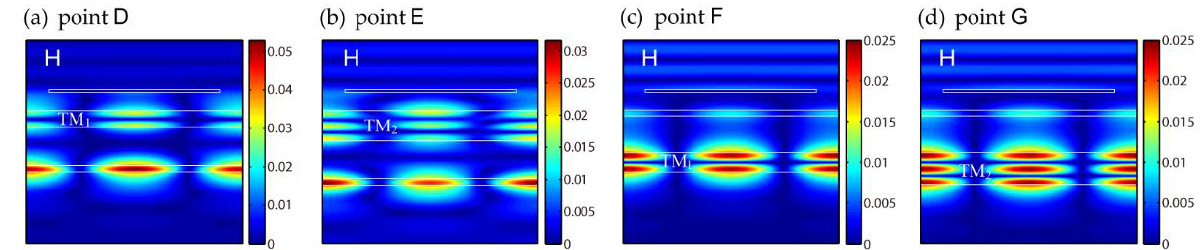
Figure 5. Magnetic field distributions of points ( a ) D, ( b ) E, ( c ) F and ( d ) G in Figure 4a,c.